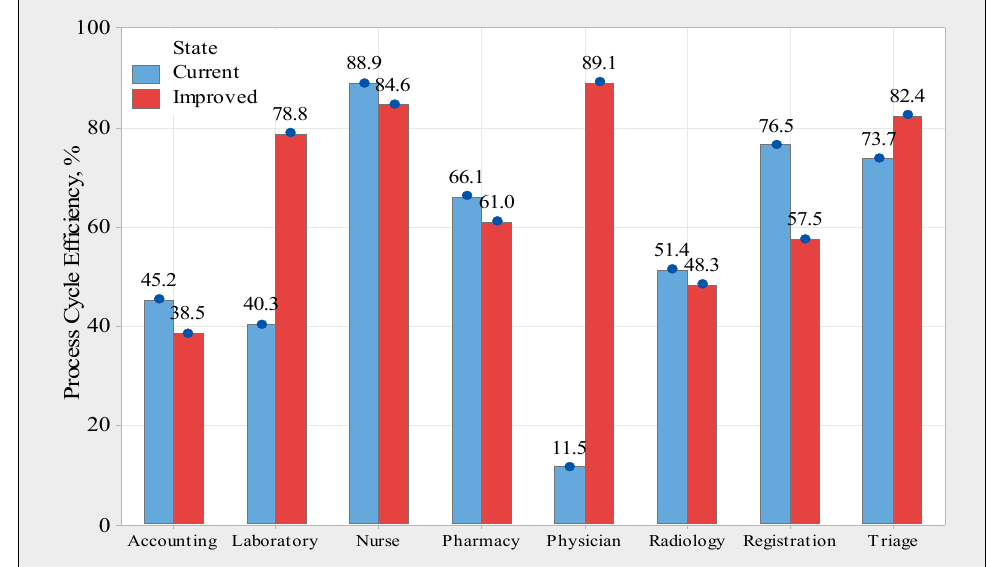
Figure 14. Comparison between the current state and improved state regarding the process cycle efficiency. Table 9. Number of patients who enter and discharge from the